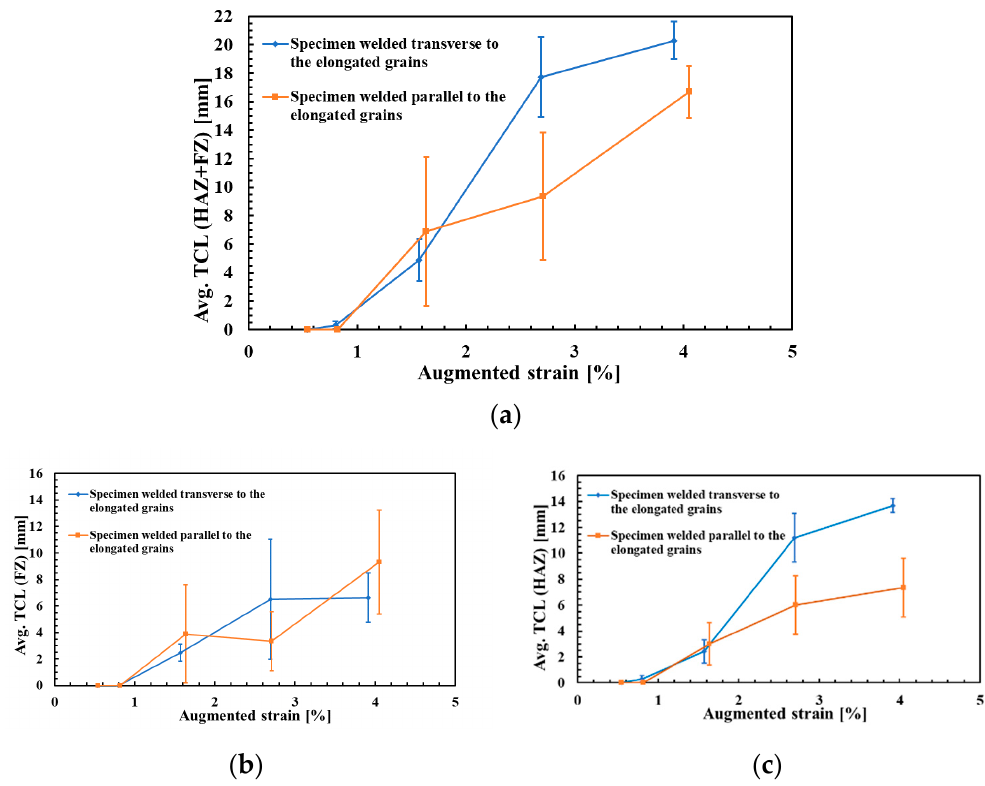
Figure 3. ( a ) Average of total crack length in both HAZ and FZ, ( b ) in just FZ, and ( c ) in just HAZ, versus augmented strain, in specimen welded parallel and transverse to the elongated grains.